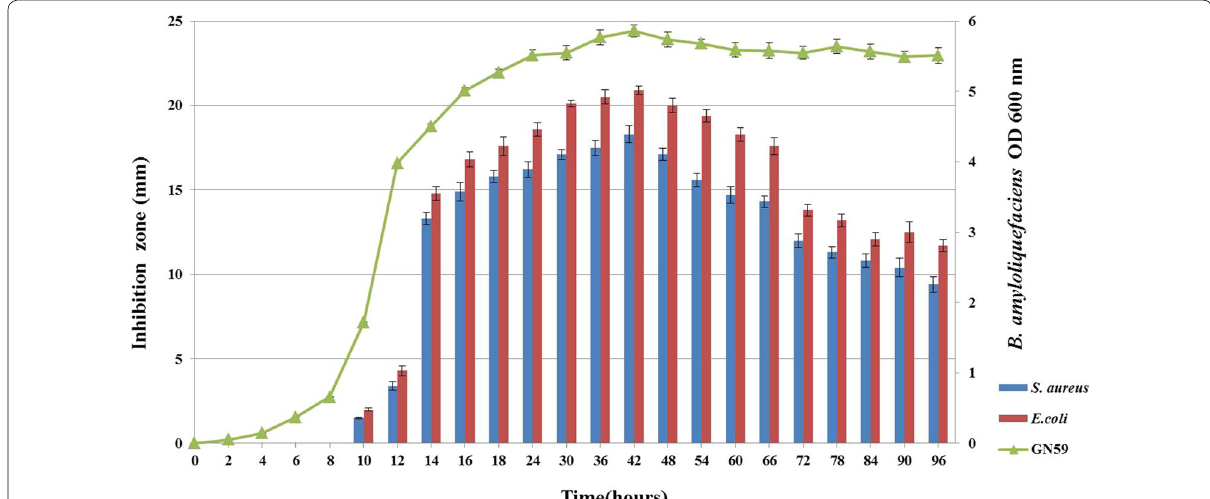
Fig. 1 The production of antibacterial compound from B. amyloliquefaciens GN59. The production of secondary metabolites displayed as sizes of the inhibition zones against S. aureus (blue bars) and E. coli (red bars) by the agar well diffusion method on the left Y axis and growth curve as measured at OD600 nm of GN59 was plotted on the right Y axis. X axis represented the time in